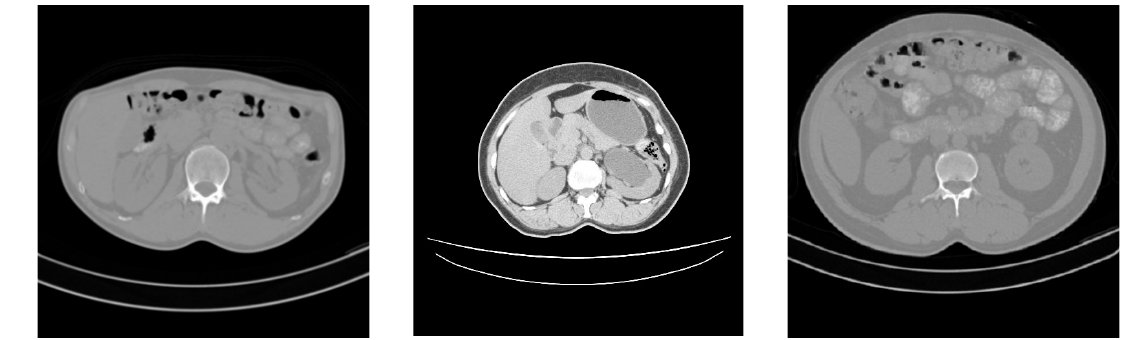
Figure 1. CT image samples.